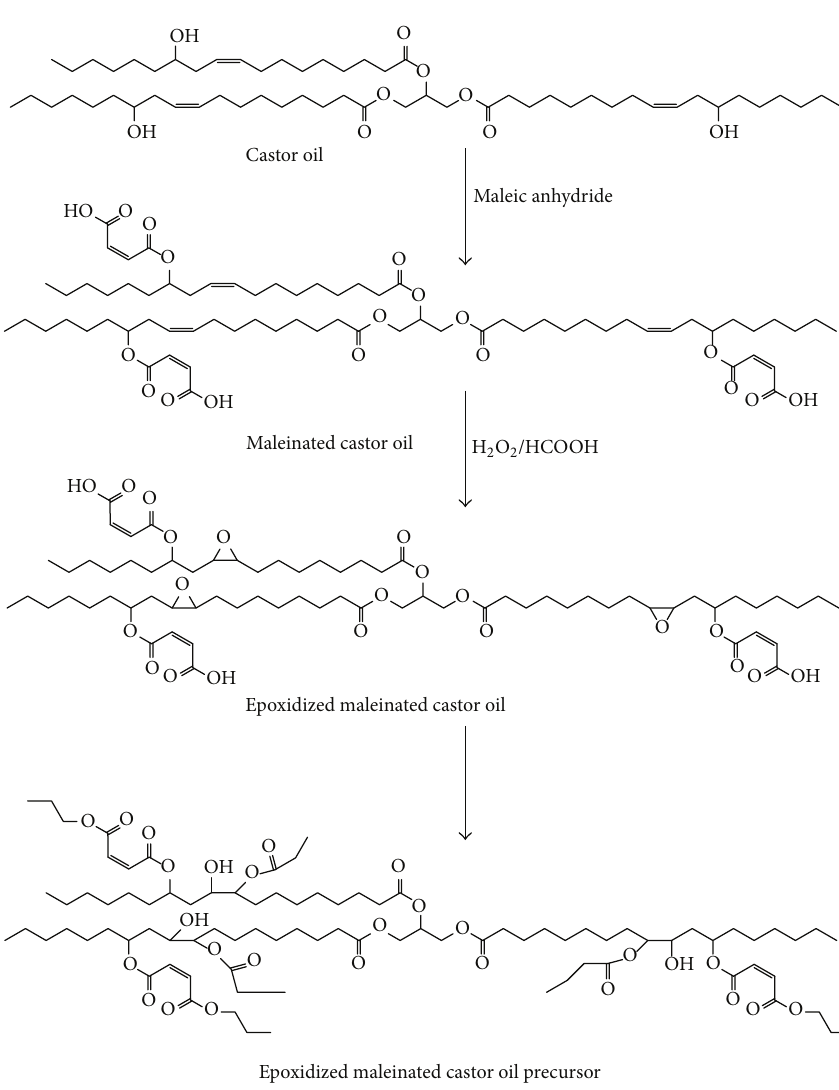
Figure 1: Synthesis of EMACO and